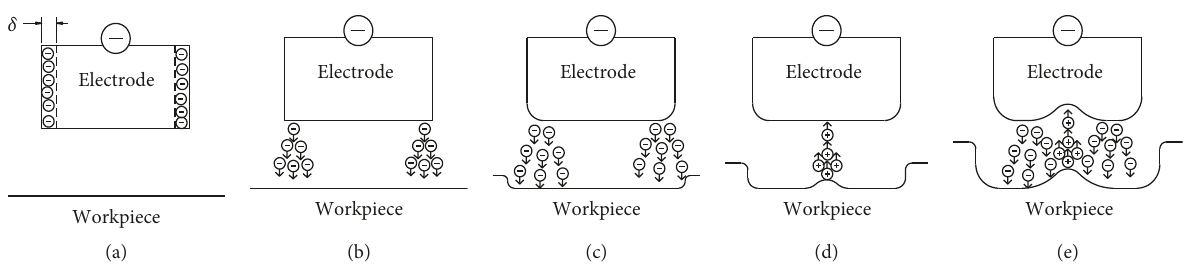
Figure 4: Graphic of the changing process of the electrode bottom (positive polarity machining).